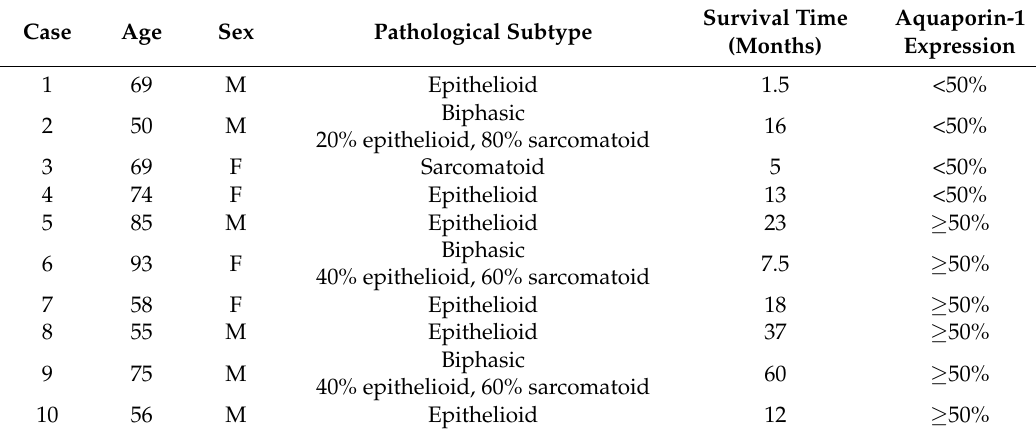
Table 1. Clinicopathological features of all studied cases of fluoro-edenite (FE)-related malignant pleural mesothelioma